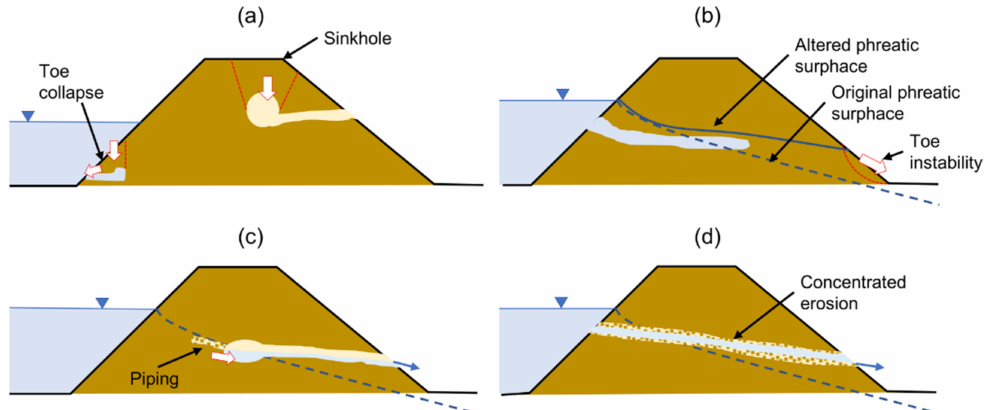
Figure 1. Effect of animal burrows: ( a ) structural weakening, ( b ) altering pressure distribution, ( c ) favoring piping, ( d ) starting concentrated erosion.